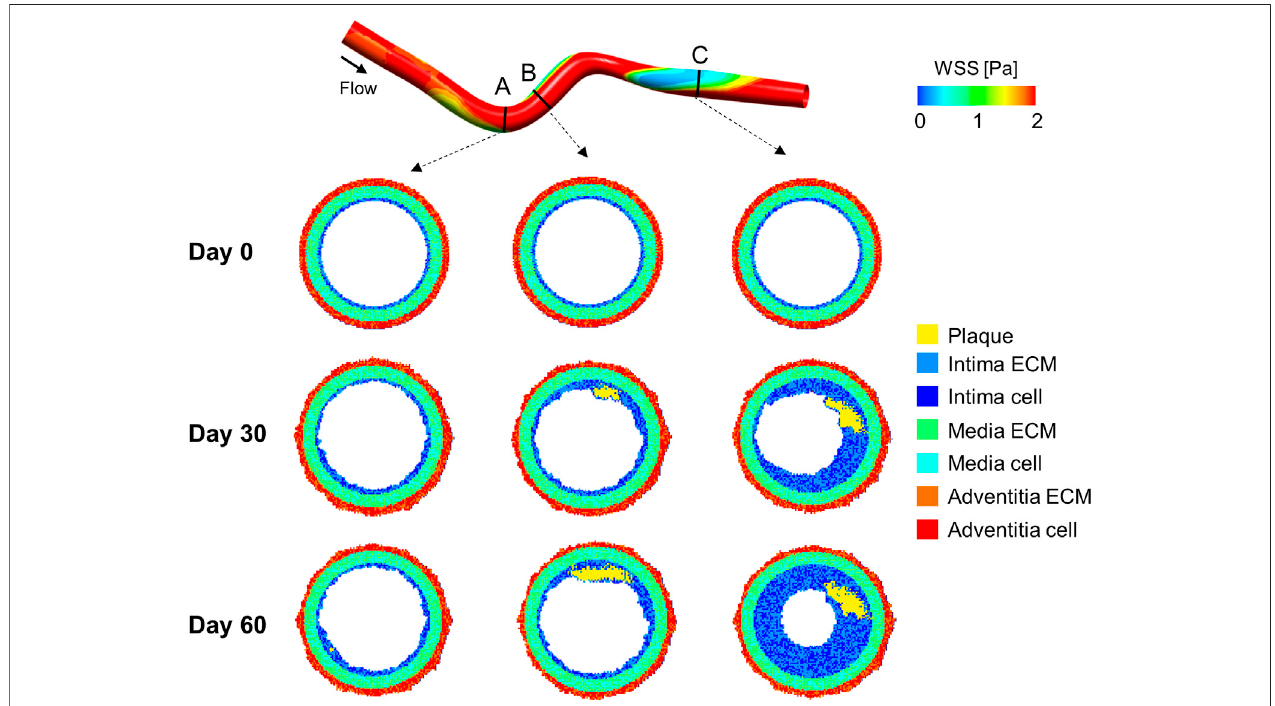
FIGURE 6 | Results of the computational fl uid dynamics – agent-based model (CFD-ABM) framework of atherosclerosis by Corti et al. (2020). At the top, the idealized 3D geometry ofa super fi cial femoral artery is represented, with thewall shear stress (WSS) luminal distribution computedfrom steady-state CFD simulation. At the bottom, the ABM temporal evolution of three representative cross-sections is presented at day 0, 30 and 60. Greater plaque formation and lumen area reduction is obtainedatluminalregionsexposedtolowWSS,suchasdownstreamfromthecurvature(planesBandC).Theplanesinvolvedintheatherogenicprocess(planes B and C) present an asymmetric plaque characterized by the presence of a well-de fi ned lipid core (in yellow) and an increased intimal extracellular matrix (ECM) and smooth muscle cell (SMC) content (blue and light-blue, respectively).